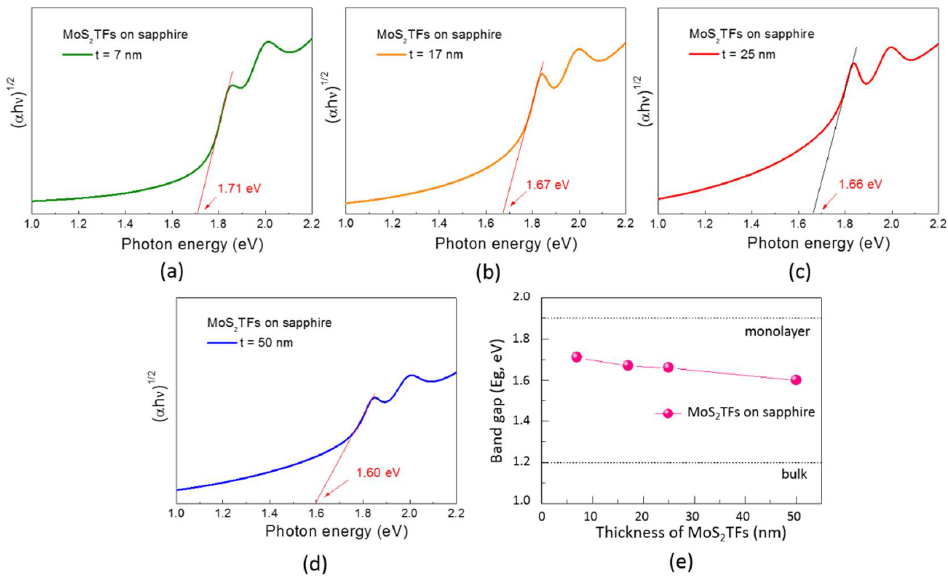
Figure 6. Tauc plots for the estimation of the band gap of MoS 2 TFs on sapphire with thickness increasing from ( a ) 7 nm, ( b ) 17 nm, ( c ) 25 nm, to ( d ) 50 nm, respectively. ( e ) The band gap of MoS 2 TFs as a function of thickness.